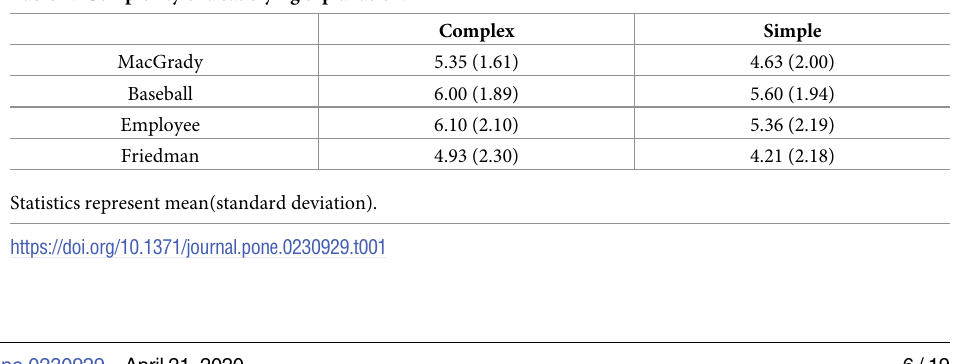
Table 1. Complexity of a satisfying explanation.